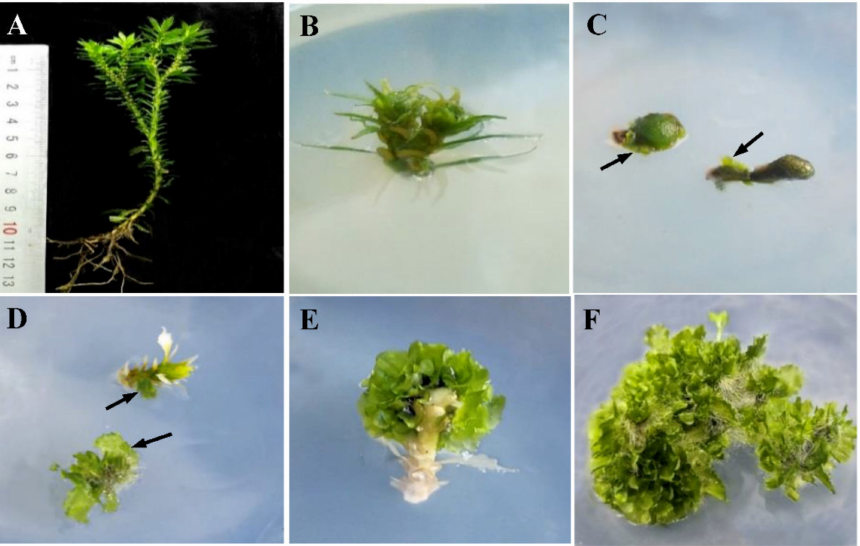
Figure 2. In vitro micropropagation process of H. serrata . ( A ) Wild plant of Fujian genotype. ( B ) Inoculated stem. ( C ) Regeneration from callus, arrows shows the regenerated thallus. ( D , E ) Thallus regeneration from spores on stems. ( F ) Thallus